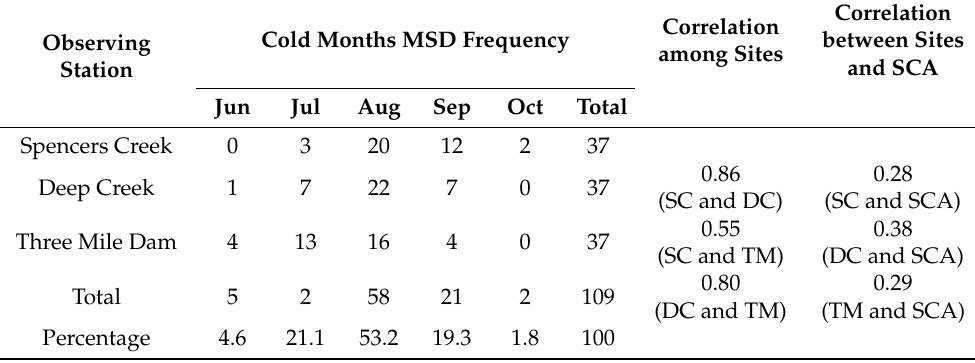
Table 2. MSD frequency during the cold months and linear correlation coefficients among the three SD observations sites.